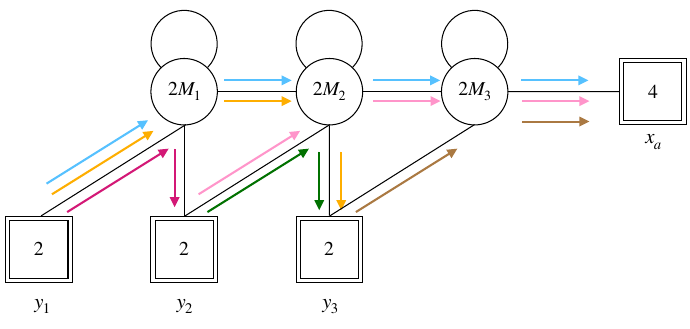
Figure 5 . Construction of some of the gauge invariant operators for N = 3 . The mesons in violet, orange and green correspond to E (12) in blue, pink and